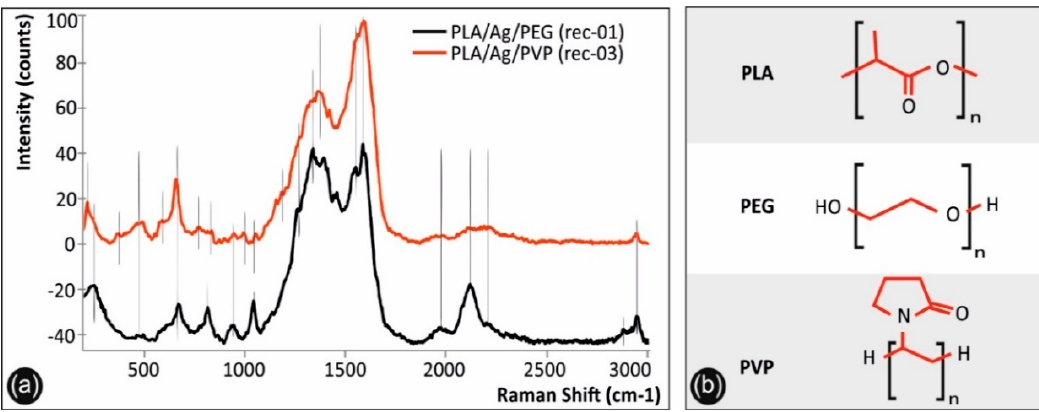
Figure 3. ( a ) Raman spectra of PLA/Ag/PEG and PLA/Ag/PVP 3D printed samples, and ( b ) the molecular structures of PLA, PEG, and PVP compounds of which the Raman characteristic features have been assigned.